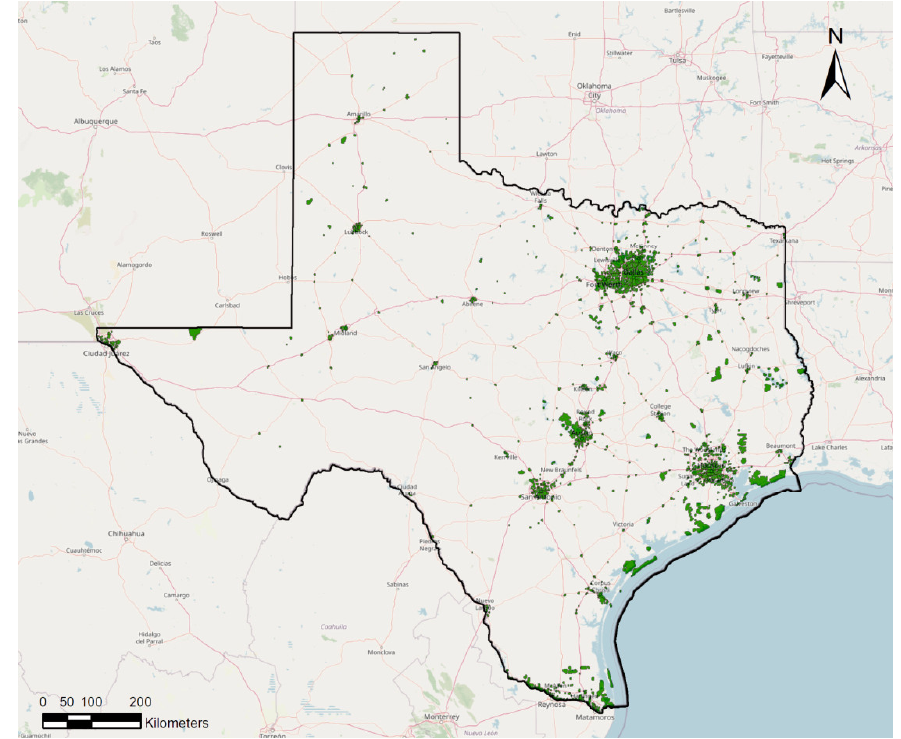
Figure 2. Distribution of green spaces in Texas.